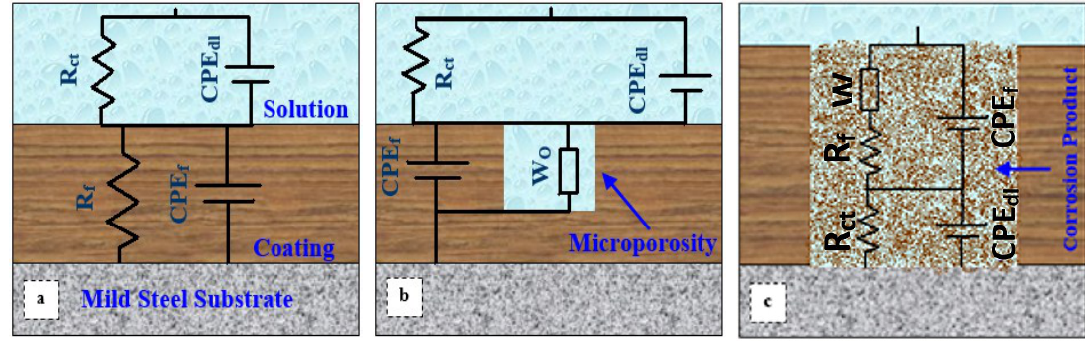
Figure 6. Proposed equivalent circuits to fit long-term EIS results for; ( a ) the first 22 h; ( b ) the next 408 h and ( c ) the last 840 h of